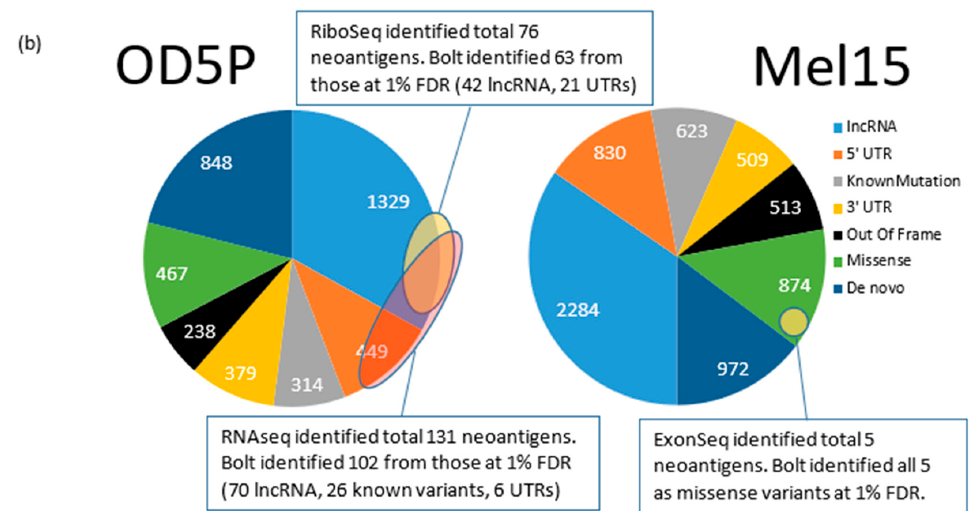
Figure 1. Non-canonical identifications by Bolt in the Mel15 and OD5P data sets. ( a ) Counts of various types of unique identifications in the ultra large database search. Identifications are categorized into four categories: peptides with modifications (common and uncommon), peptides from non-canonical origins, variant peptides (known and all possible missense), and de novo sequences. ( b ) Left pie chart shows the predicted neoantigens from Bolt’s results for the OD5P data set and its intersection with RNAseq and RiboSeq results. Right pie chart shows the predicted neoantigens from Bolt’s results for Mel15 data set (HLA I) and its intersection with ExonSeq